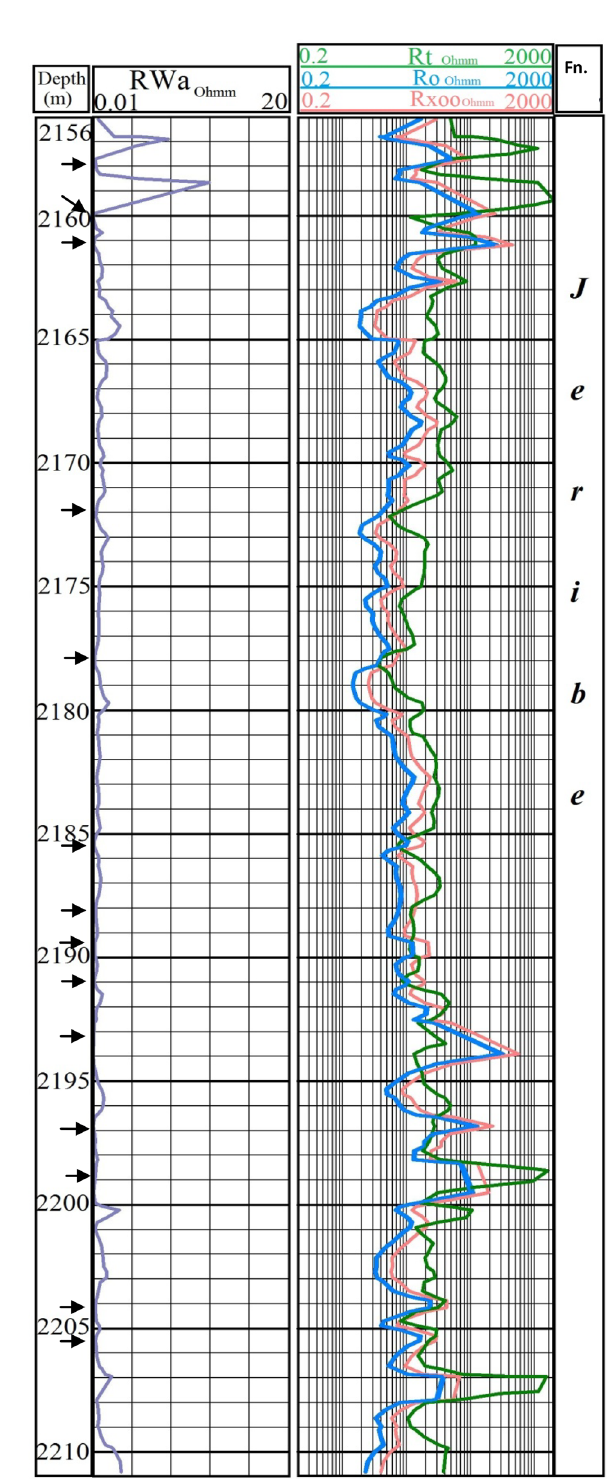
Fig. 3 R wa presentation as QLM for determining water- and hydro- carbon-bearing zones for Jeribe Formation in the well Ja-49 (black arrows are water-bearing or lowest hydrocarbon-bearing horizons)